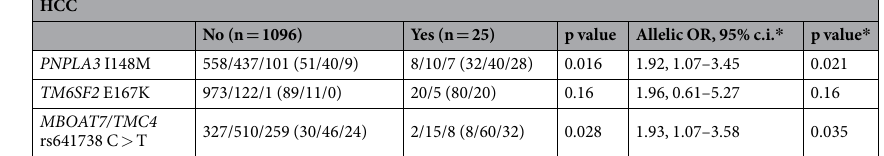
Table 5. Independent predictors of hepatocellular carcinoma (HCC) in 1121 non-cirrhotic patients with chronic liver diseases associated with hepatic fat accumulation (597 with chronic hepatitis C and 524 with alcoholic liver disease). (): % values; OR: odds ratio; c.i.: confidence interval. Comparisons were performed by logistic regression setting HCC as dependent variable, and the association of genetic variants was analyzed assuming additive models. * Adjusted for age, sex, liver disease etiology, and PNPLA3 , TM6SF2 and MBOAT7/ TMC4 genetic